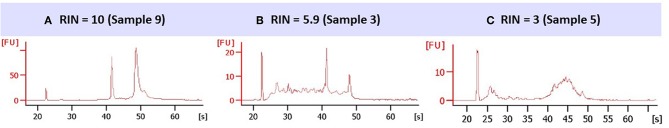
Representative electropherogram for different RIN classes. 1 μL of sample RNA was charged in the microfabricated chips. (A) RIN = 10, from one representative sample classified as score 4; the different regions (pre-, 5S-, fast-, inter-, precursor-, post-region) and peaks (marker, 18S, 28S) are correctly presented. (B) RIN = 5.9, from one representative sample classified as score 3; intermediate peaks appear on the zone 5S and fast-regions, pointing to RNA degradation. (C) RIN = 3, from one representative sample classified as score 2; peaks of ribosomal subunits, 18S and 28S, are absent.